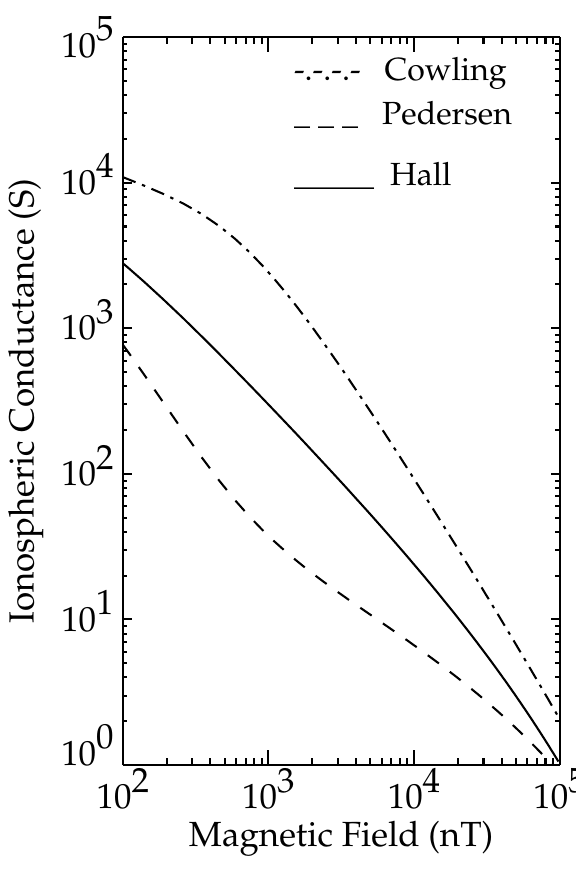
Fig. 4. Dependence of the dayside ionospheric conductances on the ionospheric magnetic field